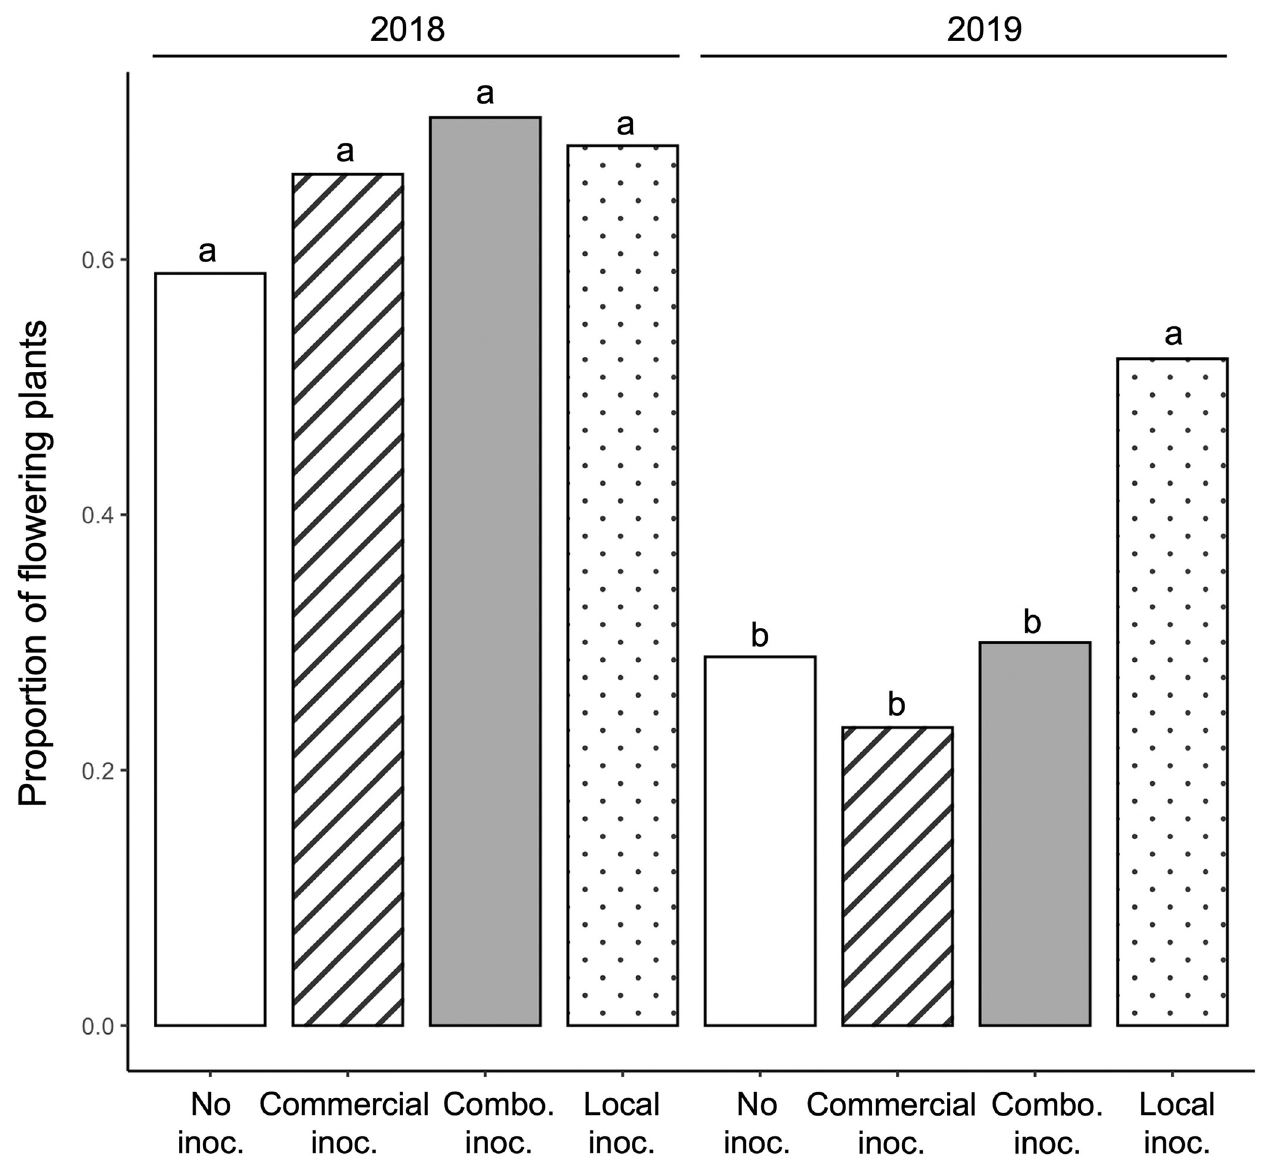
Fig 1. Proportion of plants that flowered in 2018 and 2019 in each of the four treatments. Results were analyzed using an analysis of variance. Letters denote significant differences among treatments and year using a post-hoc Tukey’s HSD test. The combination soil treatment is abbreviated as “Combo inoc.”.